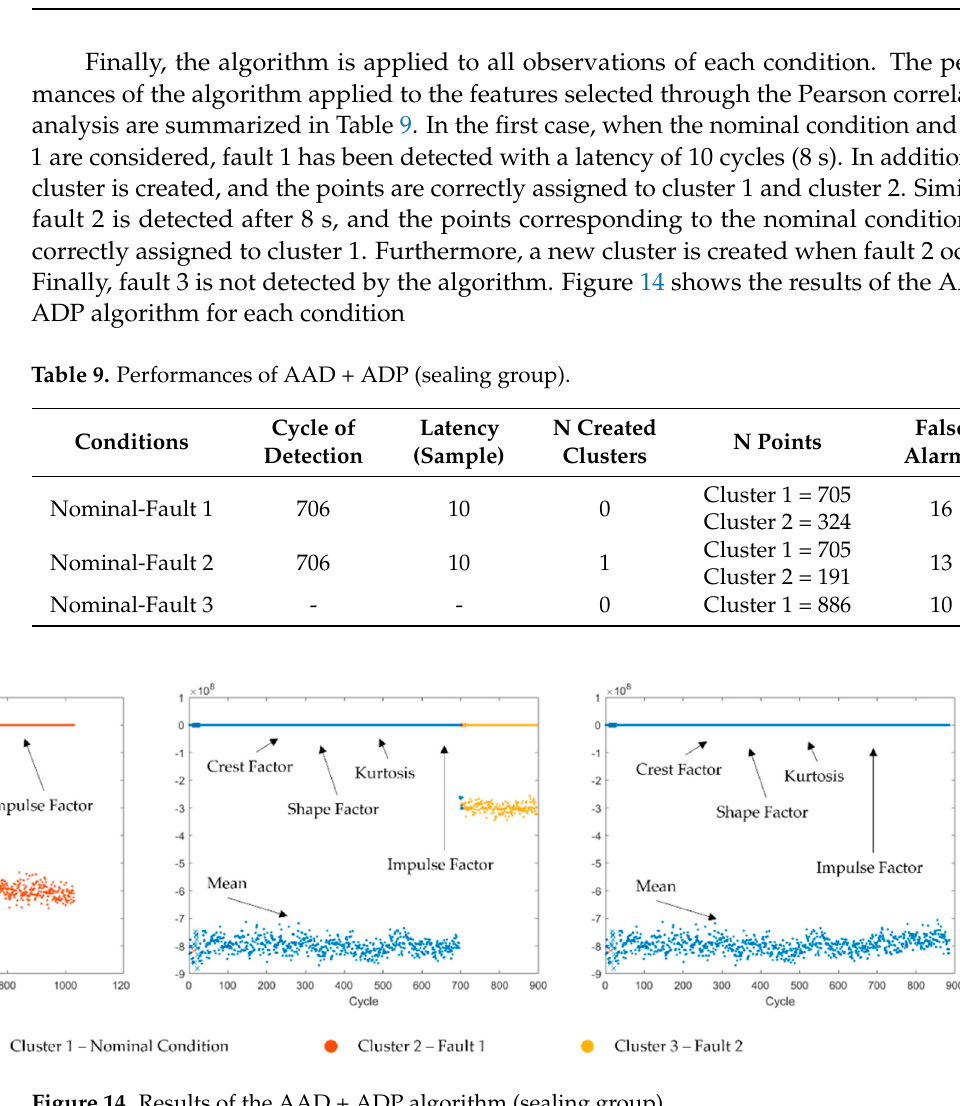
Figure 14. Results of the AAD + ADP algorithm (sealing